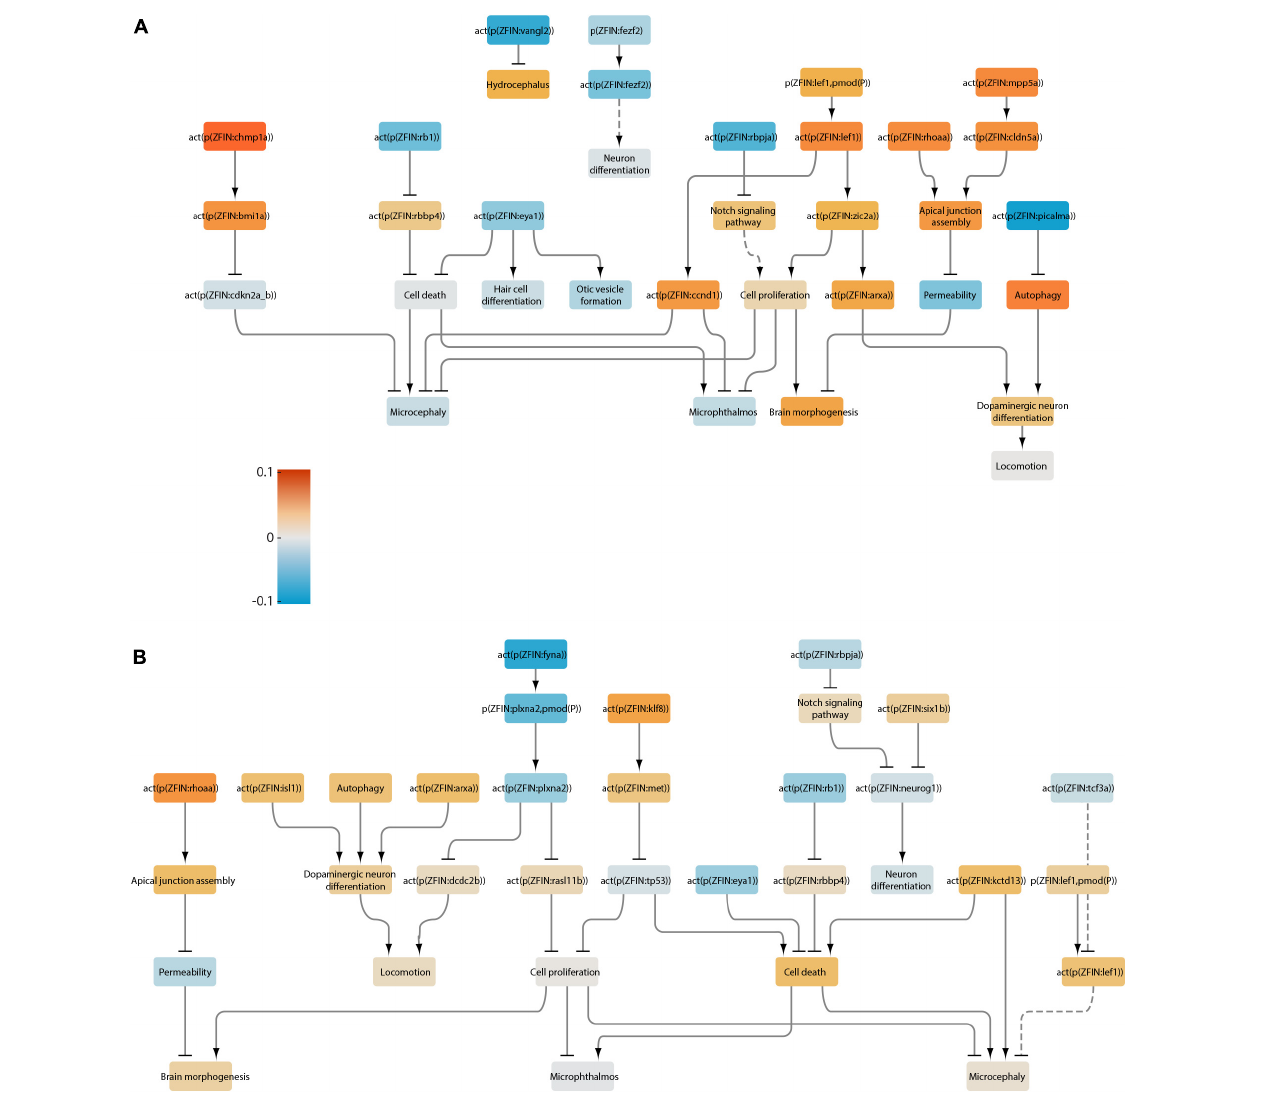
FIGURE 6 | Neurotoxicity network scored with the transcriptomes of larvae treated with lead. (A) 72-hour exposure. (B) 120-hour exposure. Increased and reduced activity for each node is color-coded according to the heatmap. Dotted lines represent indirect connections in the main network.